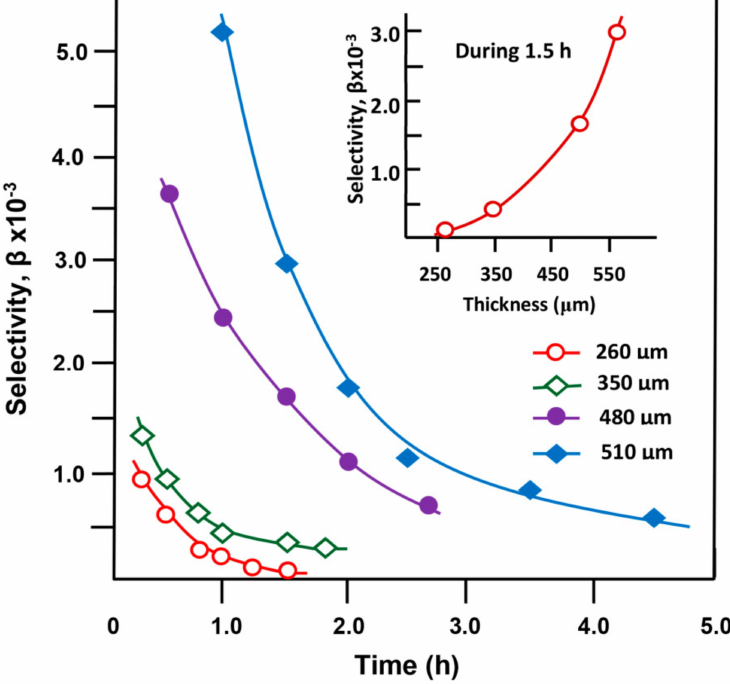
Figure 5. Variation of the membrane selectivity versus time obtained at different thicknesses. Condi- tions: temperature, 20 ◦ C and stirring rate, 500